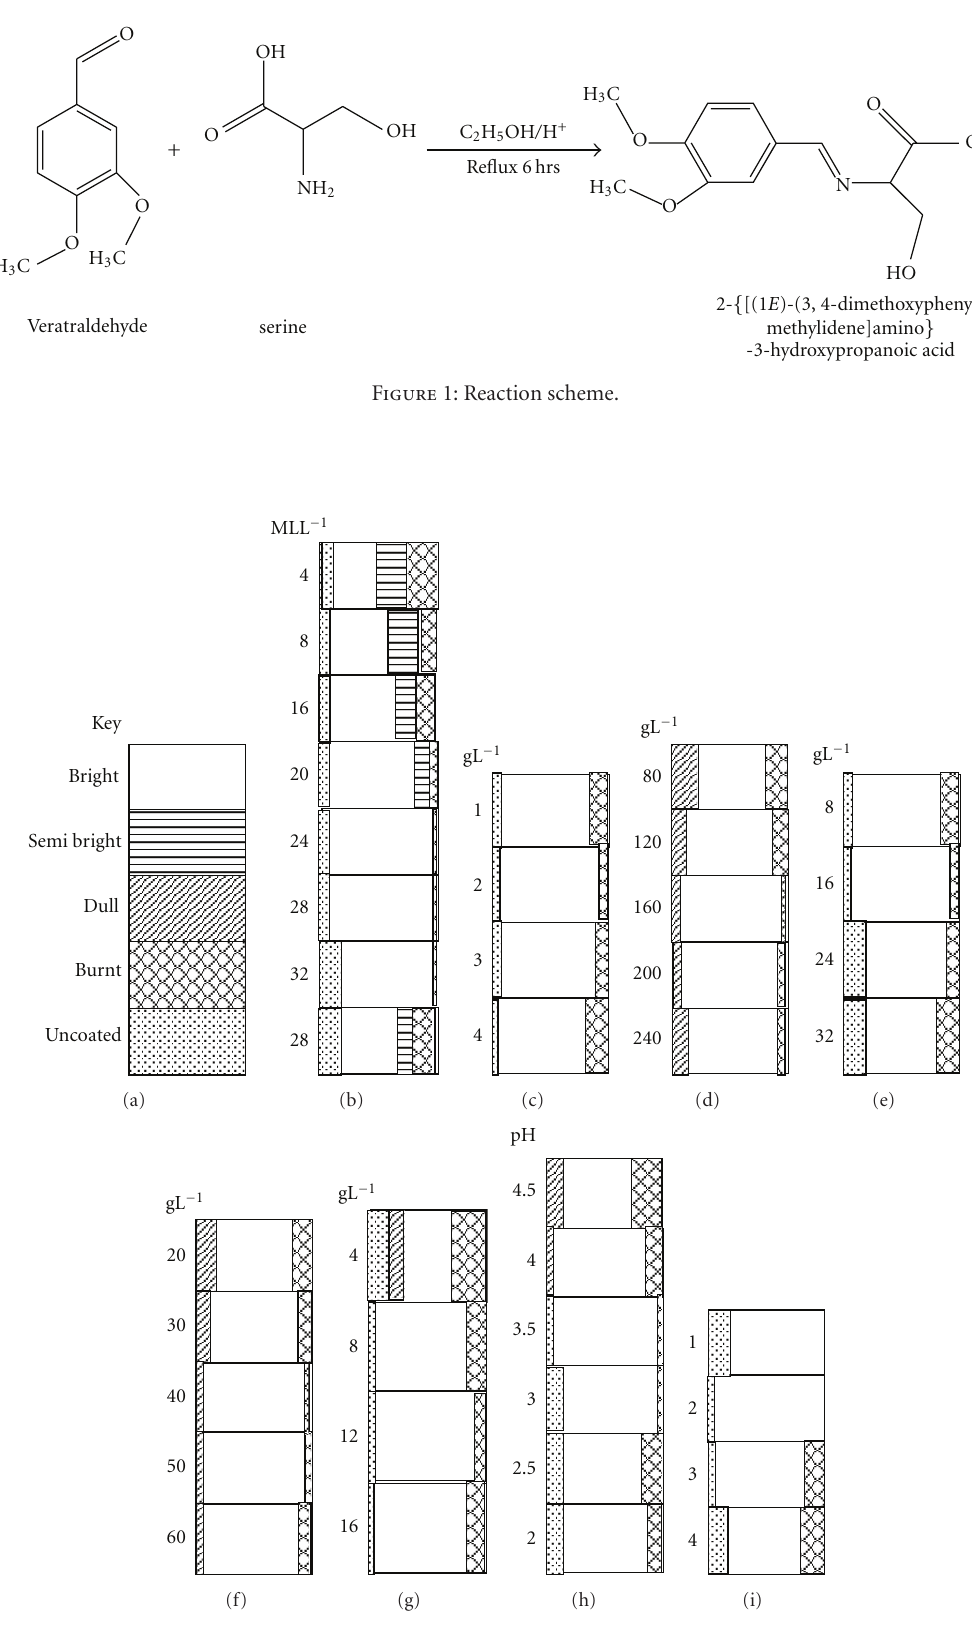
Figure 2: (a) Key, (b) brightener, (c) CTAB, (d) ZnSO 4 , (e) FeSO 4 · 7H 2 O (f) Na 2 SO 4 (g) H 3 BO 3 (h) pH, and (i) current